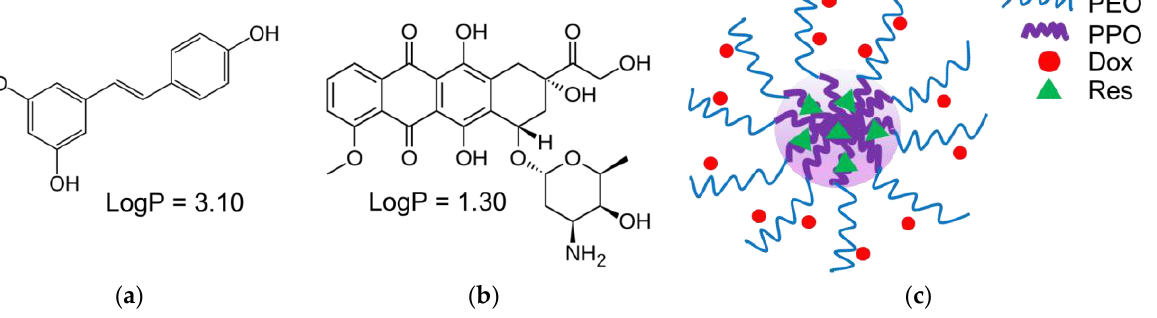
Figure 2. Structures and partition coefficients of resveratrol ( a ) and doxorubicin ( b ) and schematic presentation of their loading in the micelles ( c ).